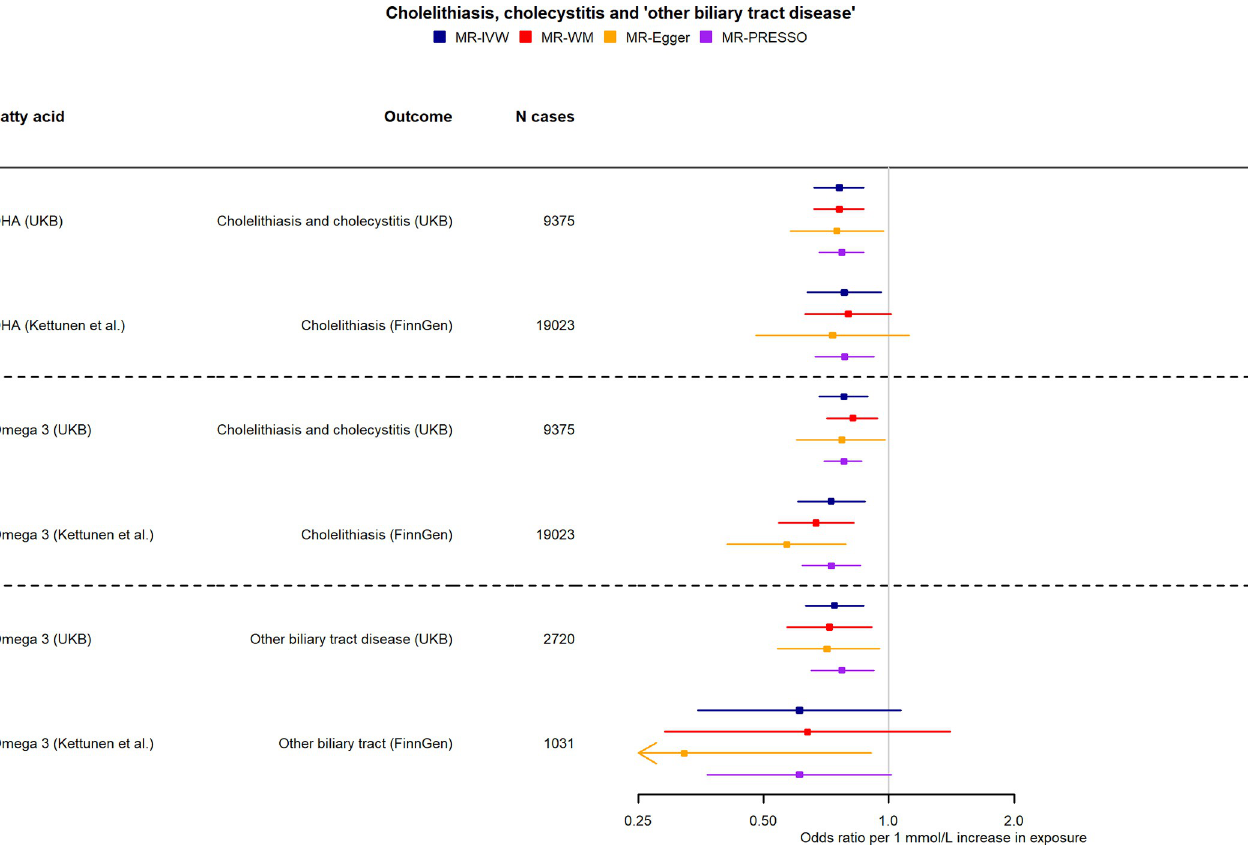
Fig 4. Two-sample MR effect estimates per 1 mmol/L higher fatty acids for cholelithiasis, cholecystitis, and “other biliary tract disease” in (a) using betas from UKB and (b) using betas from Kettunen and colleagues [20] for fatty acids and FinnGen (https://r5.finngen.fi/) for cholelithiasis. Only associations between genetically predicted fatty acids and biliary tract health outcomes with statistically significant ( P < 0.05) IVW MR estimates in UKB are shown. DHA, docosahexaenoic acid; IVW, inverse-variance weighted; MR, mendelian randomisation; UKB, UK Biobank; WM, weighted-median.